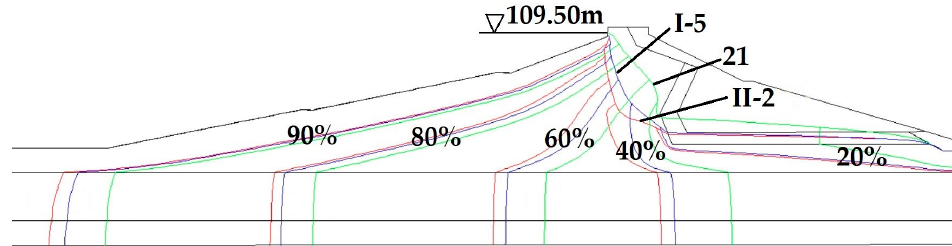
Figure 14. Equipotential lines of unsteady seepage at representative moments. (i.e., Condition I-5 indicates the fifth day in condition indicates the fifth day in condition I).